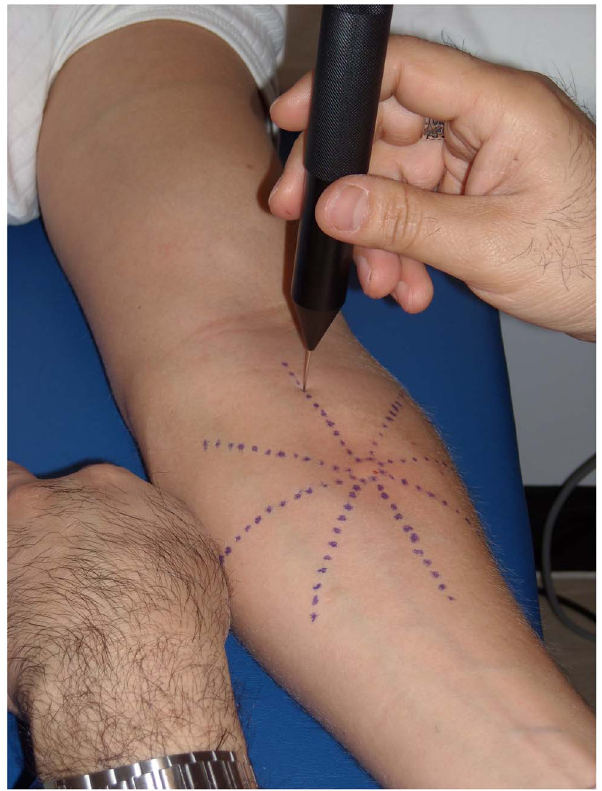
Figure 2. Capsaicin model. The dots represent the points where stimulation was applied. The circle in the center of the hectagon is the site of capsaicin injection.